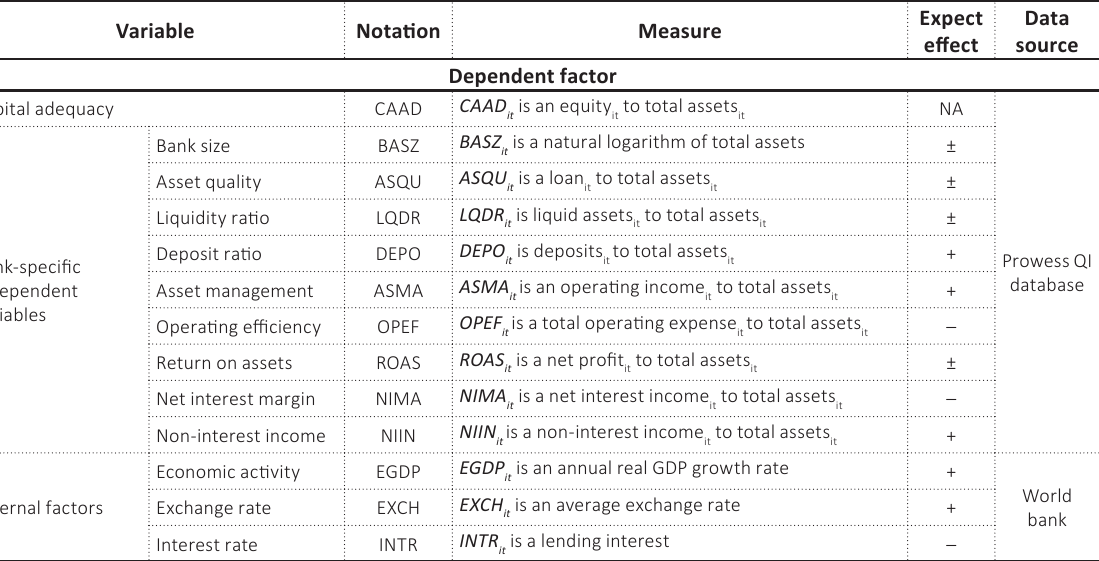
Table 1. Definitions of the